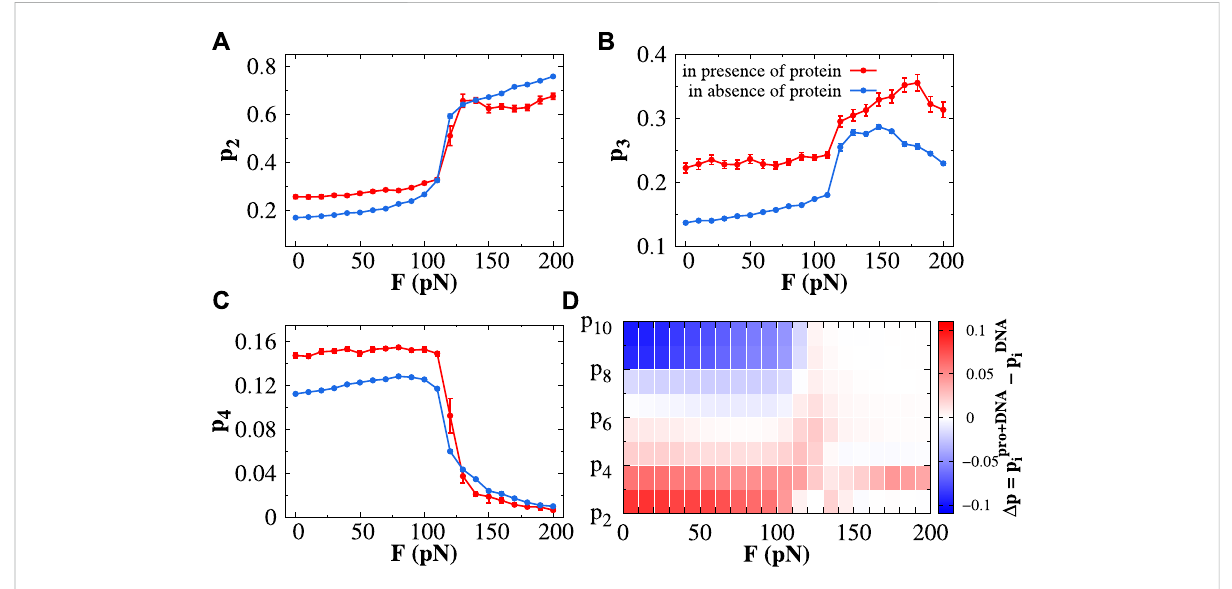
FIGURE 3 Effect of protein dynamics in the formation of base-pair clusters. The probability of forming the (A) doublet ( p 2 ), (B) triplet ( p 3 ), and (C) quadruplet( p 4 )isplottedasafunctionofstretchingforceinthepresence(redline)andabsence(blueline)ofprotein.Theerrorbarforeachsymbolis de fi ned as the standard error. (D) Presented contour plot combines the probability of forming all kinds of clusters starting from the doublet ( p 2 ) and triplet (